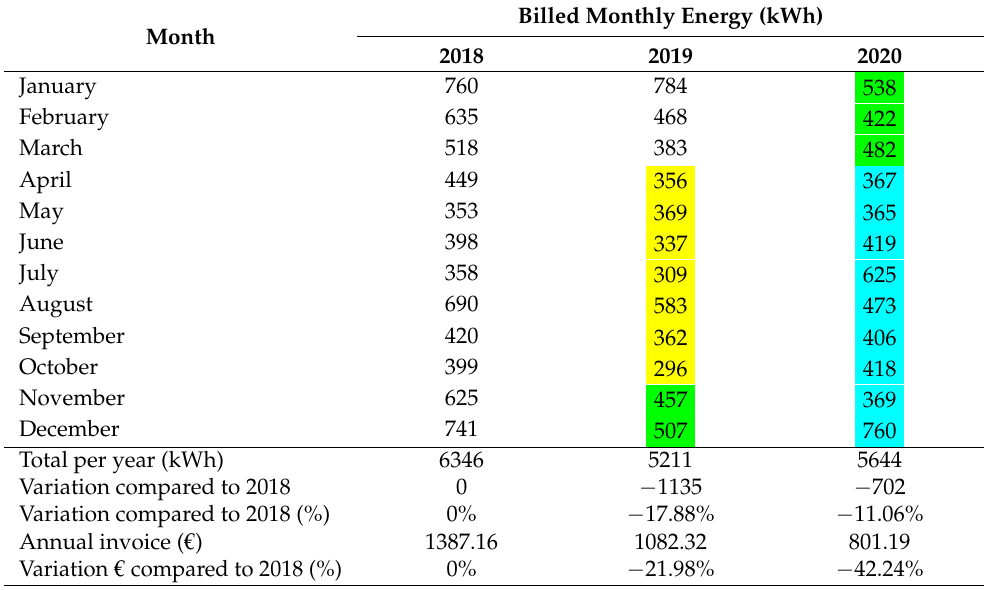
Table 7. Monthly energy billed: previous period P0; first period P1 (yellow); second period P2 (green); third period P3